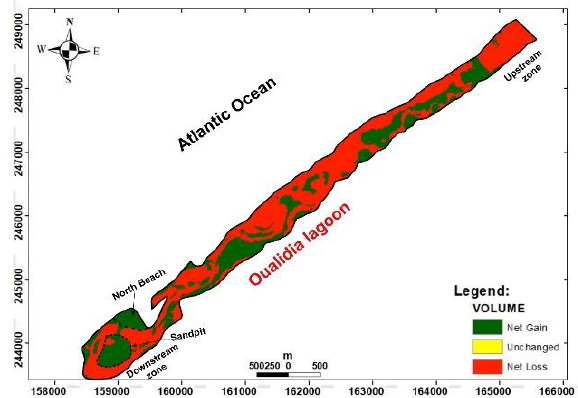
Figure 6. Spatial variability of sediment accretion and erosion in the Oualidia lagoon water bed basted on 2006 and 2012 repeated bathymetric data.